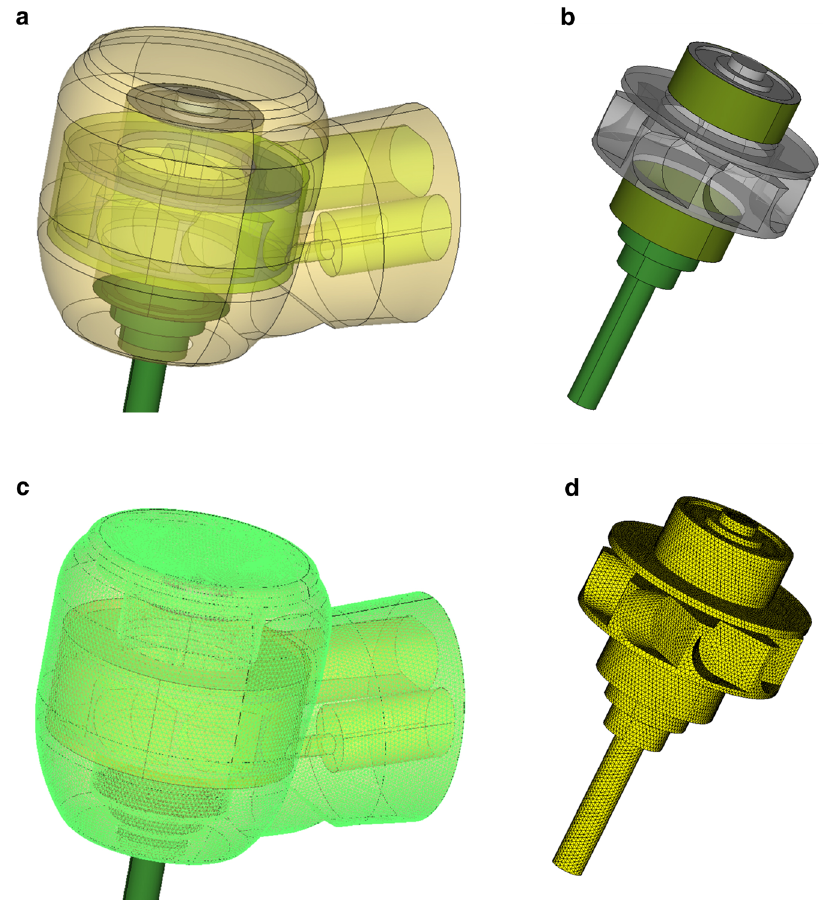
Fig. 1 3-D modelling process. a , b Reassembled components after rendering. c , d Mesh models converted from